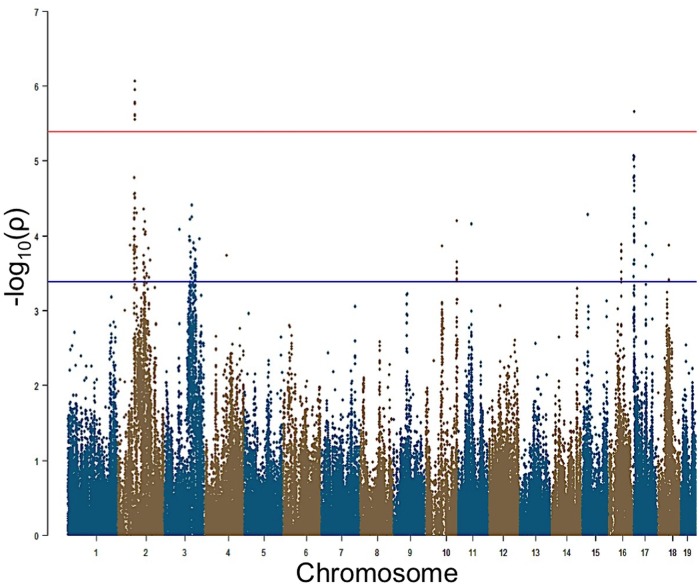
GWAS results for post-noise exposure thresholds in the HMDP.Manhattan plot showing the association (-log10) p-values (-logP) for 8 kHz in 64 HMDP inbred mouse strains. The analysis was performed using 108,064 SNPs with a minor allele frequency > 5%. Each chromosome is plotted on the x-axis in alternating brown and blue colors. SNPs on Chr. 2 and Chr. 17 for 8 kHz exceeded the predetermined genome-wide significance threshold (-logP = 5.39).